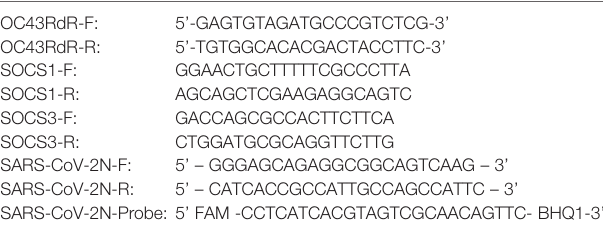
TABLE 1 | Nucleotide sequence of the primers used in qPCR